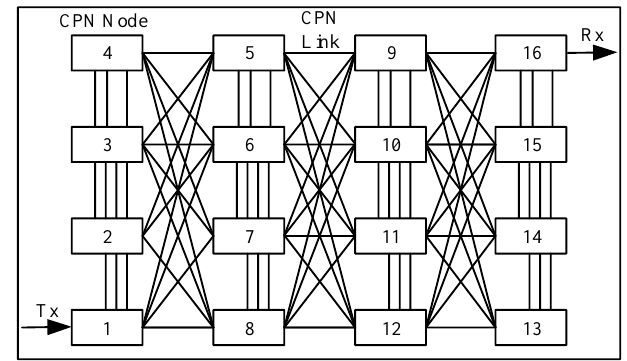
Figure 8. CPN Network (4 × 4 Nodes).